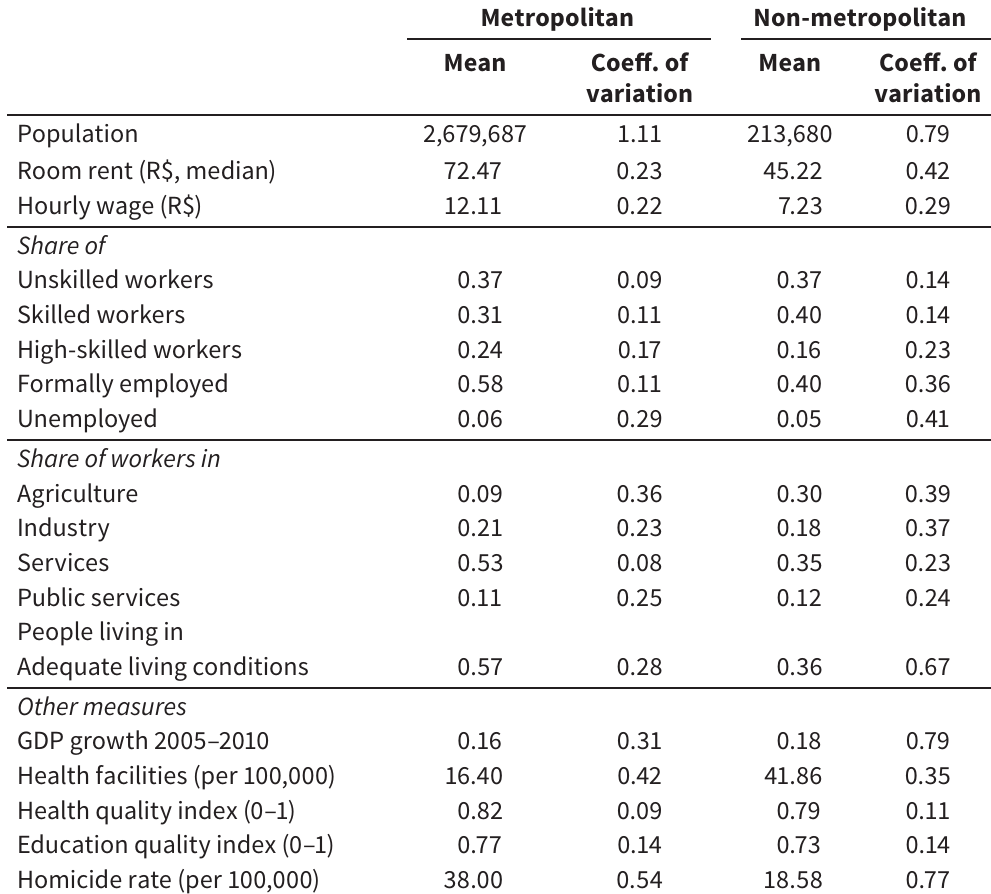
Characteristics of metropolitan and non-metropolitan microregiões in 2010